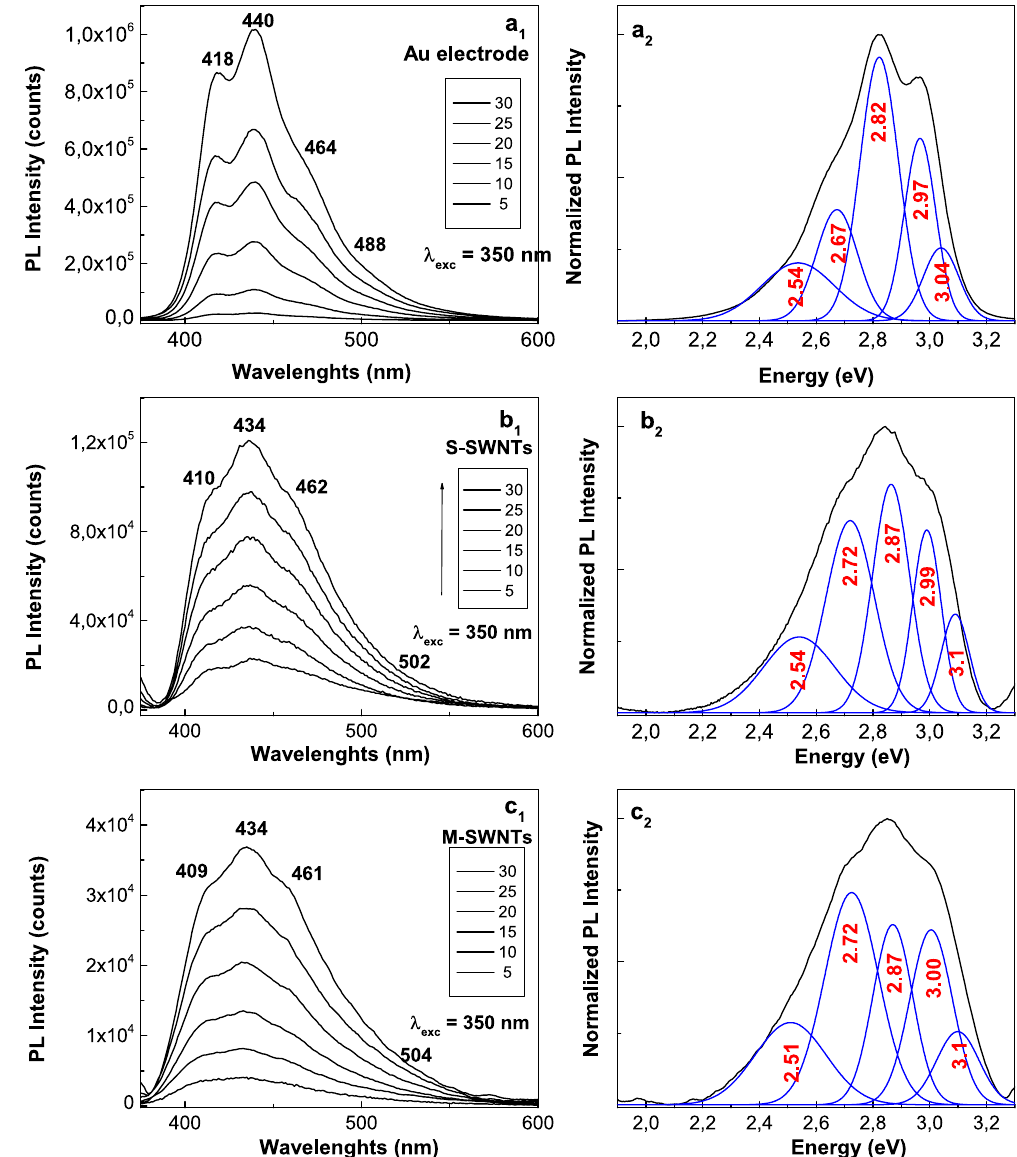
Figure 2. The PL spectra of PANI doped with HSO 4 − ions electro-synthesized onto the blank Au electrode ( a 1 ) and the Au plates covered with a film of S-SWNTs ( b 1 ) and M-SWNTs ( c 1 ) during 5, 10, 15, 20, 25 and 30 CVs. De-convolution of the PL spectra recorded after 30 CVs onto the blank Au electrode ( a 2 ) and the Au plates covered with a film of S-SWNTs ( b 2 ) and M-SWNTs ( c 2